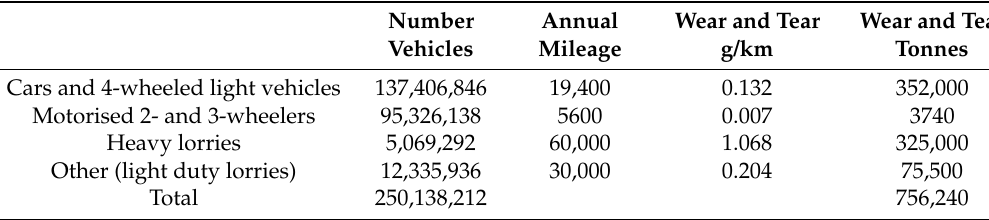
Table 9. Calculation of the amount of tyre wear and tear in China [22,35,45,46].